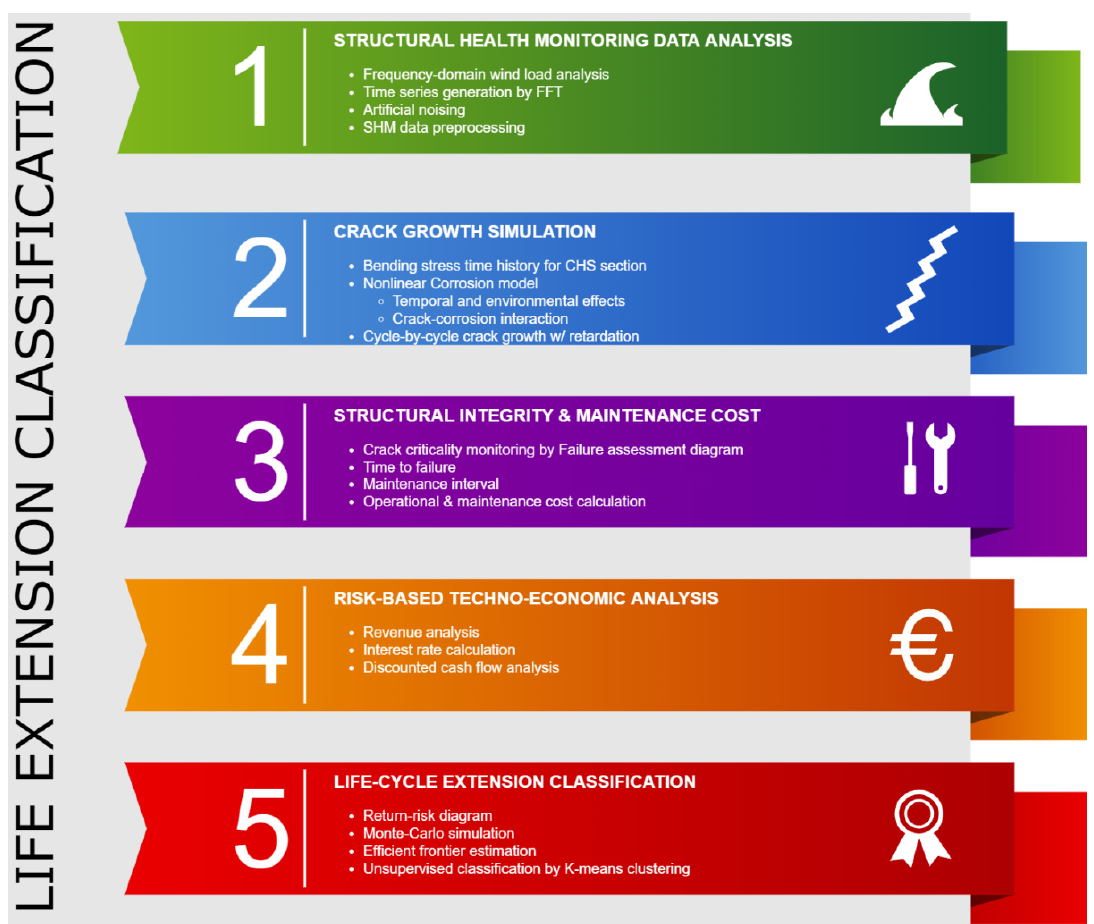
Figure 1. Flow chart for the development of life extension classification.